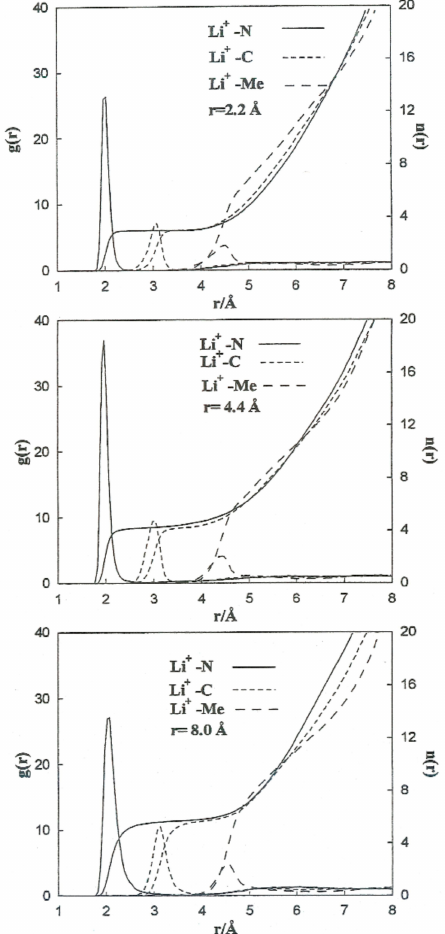
Figure 8. Radial distribution functions and running coordination numbers for Li + at various interionic separations for the Li + -Br − ion